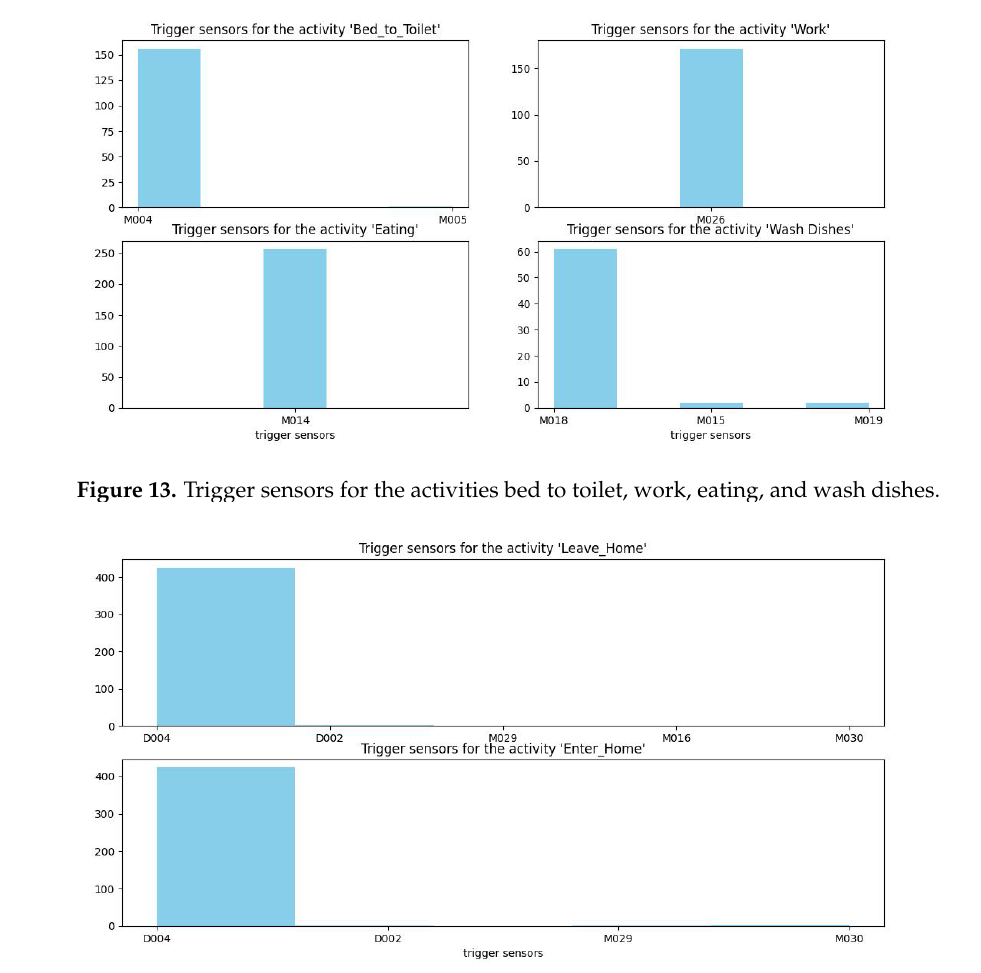
Figure 14. Trigger sensors for the activities leave home and enter